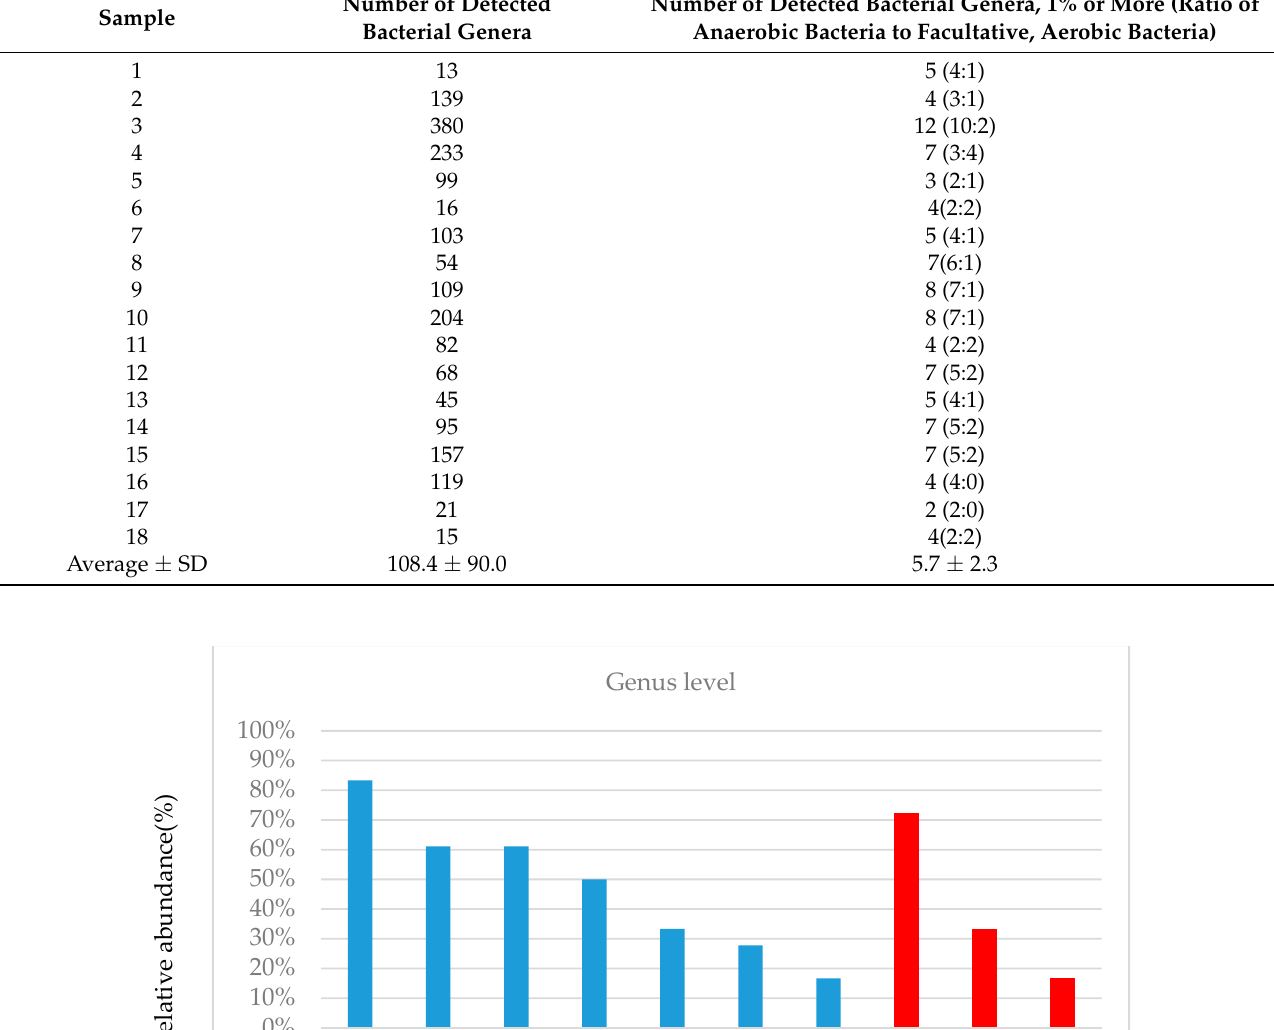
Table 4. Number of detected genera in each sample and number of detected bacterial genera of 1% or more abundance (ratio of anaerobic bacteria to facultative, aerobic bacteria).